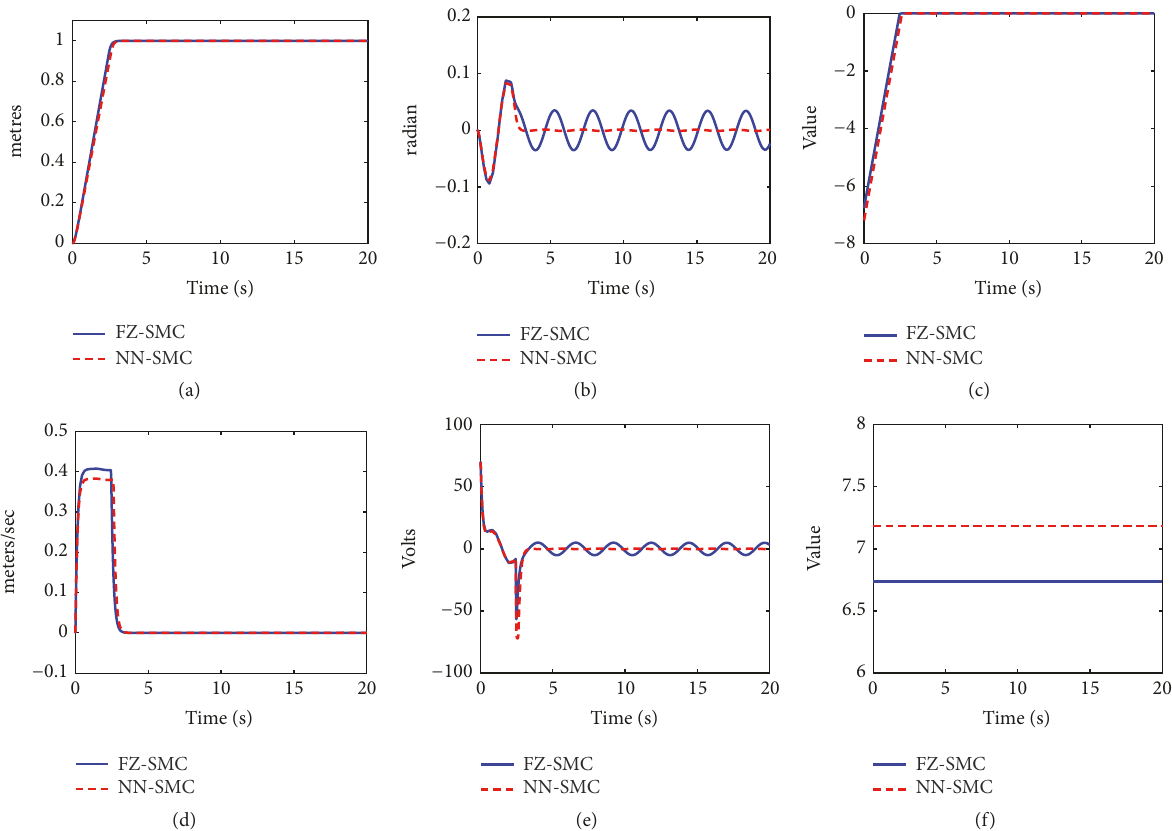
Figure 9: Responses for a hoisting height of 1.7m. (a) Cart position. (b) Payload sway. (c) Sliding manifold. (d) Cart velocity. (e) Control effort. (f) Manifold